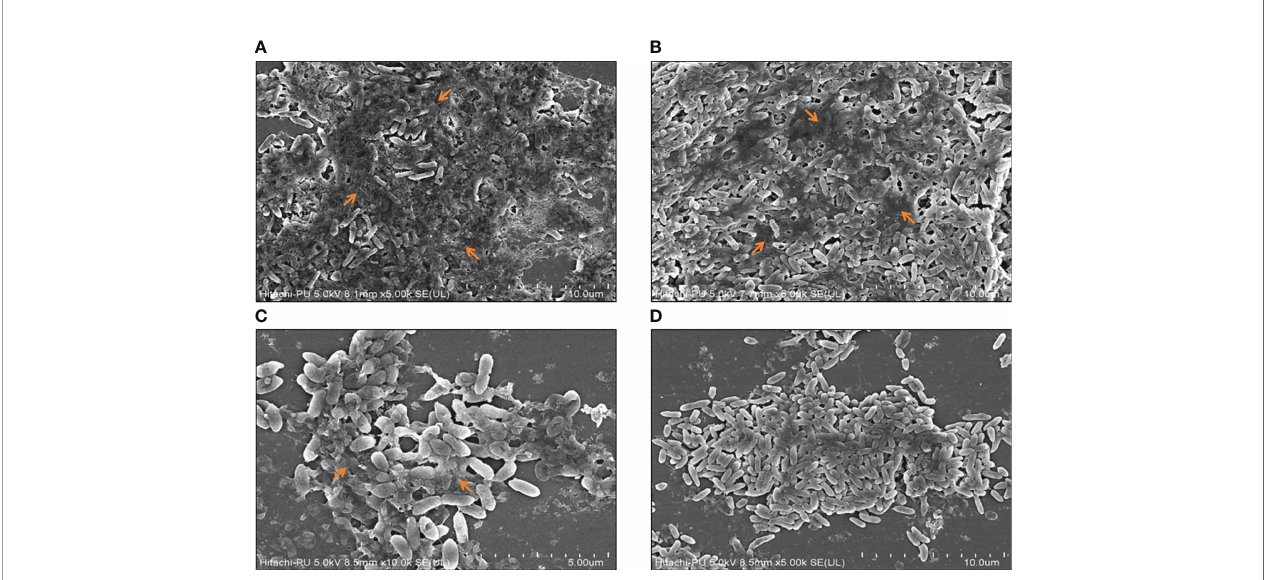
FIGURE 8 | Microscopic visualization of peak day pseudomonal bio fi lms in the presence and absence of the test drugs using FESEM. (A) Untreated control, (B) GeN-treated culture, (C) CiNN-treated culture, and (D) CiNN-GeN-treated culture. The arrows indicate EPS production within the PAO1 bio fi